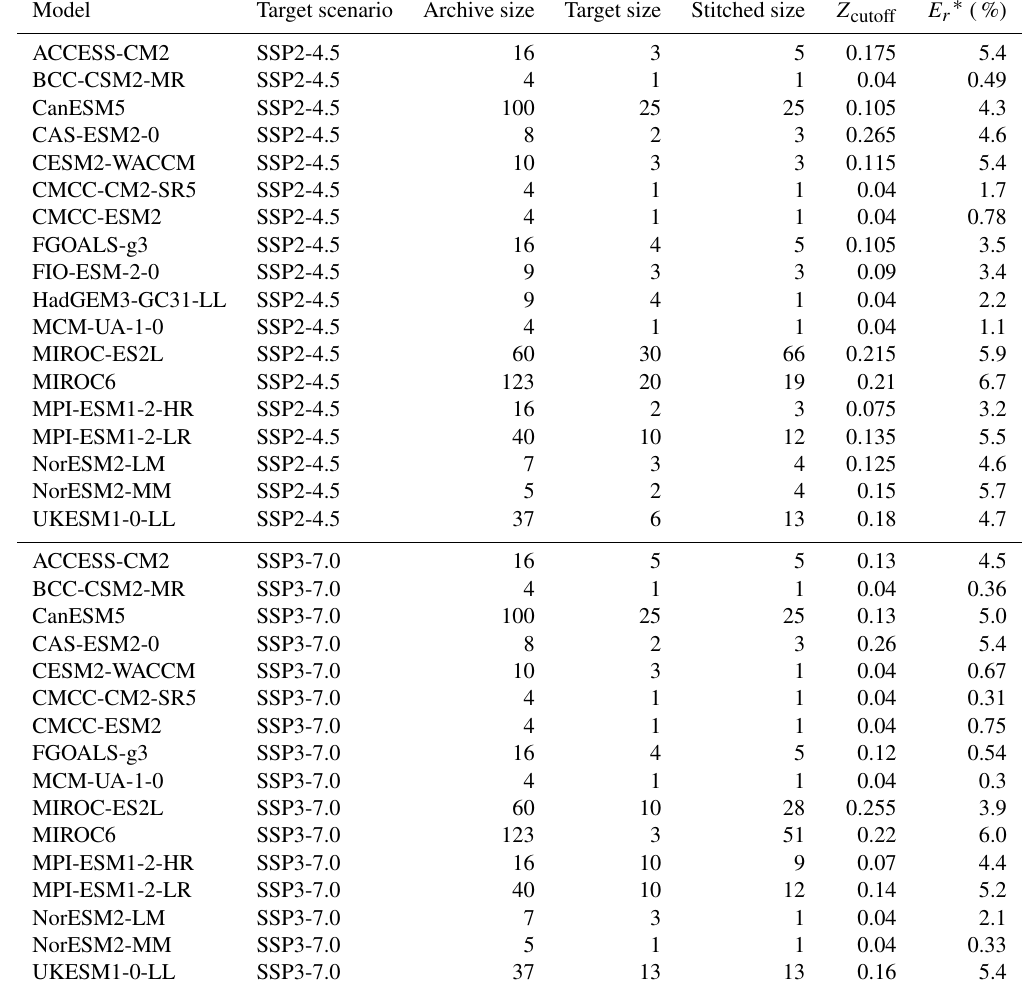
Table 5. For each ESM and the two scenarios targeted by the emulation, we show the size of the archive, the number of trajectories used as target, and the number of stitched trajectories obtained from them for the value of Z cutoff , which keeps the metric E r , when averaged across 50 draws, at the maximum value indicated along the column E r ∗ . Thus, by E ∗ r we indicate the result of averaging E 1 and E 2 (see Eq. 1) separately over the 50 draws and taking the maximum of the two average values. We refer to Sect. 3.1.3 for